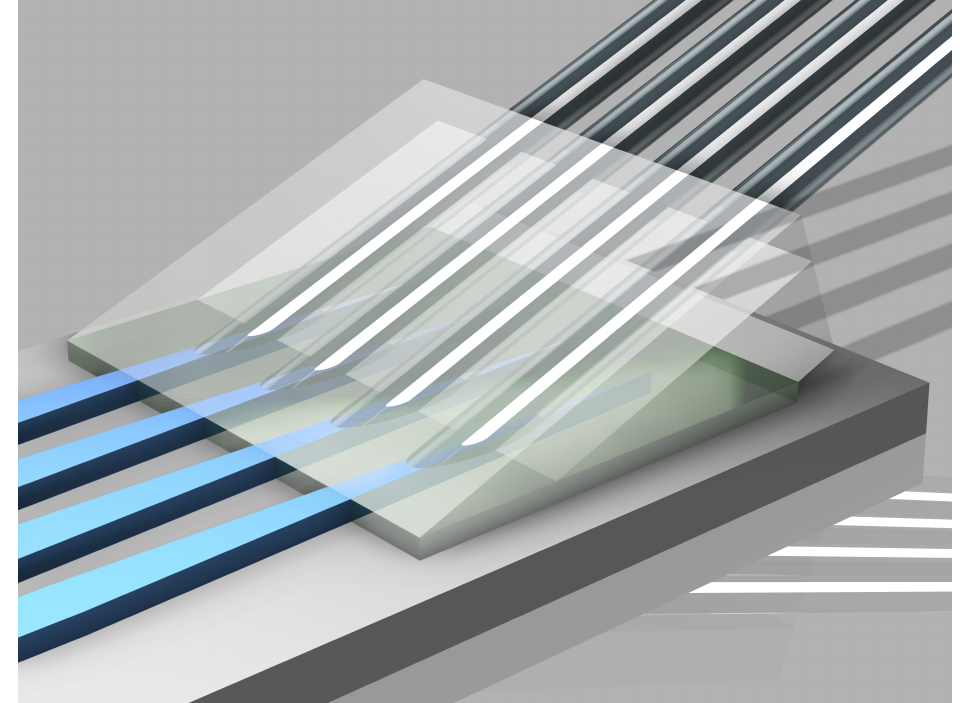
Figure 6. Artistic view of processed fiber-array block and inverse tapers. Proportion of the structure is exaggerated for clear